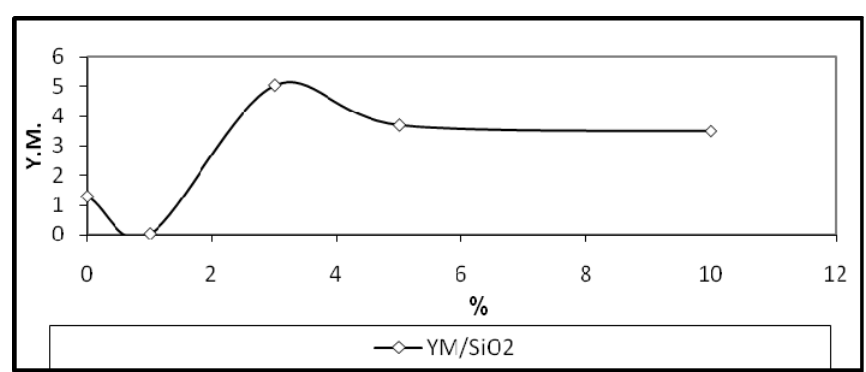
Fig. 3: Change in Young`s modulus with SiO Table 2: Main mechanical properties of polymer filled SiO